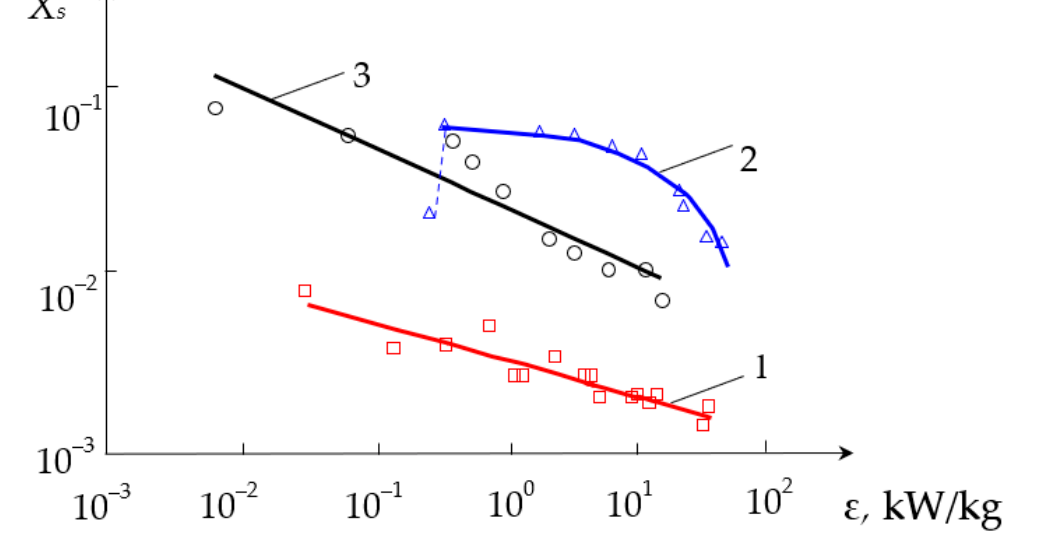
liquids supply methods: 1—(TU1, Ax), 2—(TU1, TU2), 3—(TU1, TL2).